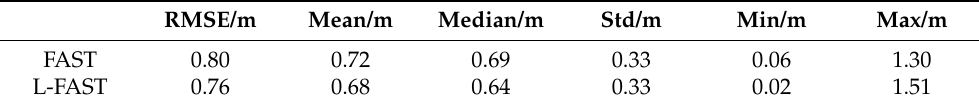
Table 3. The analysis of absolute trajectory